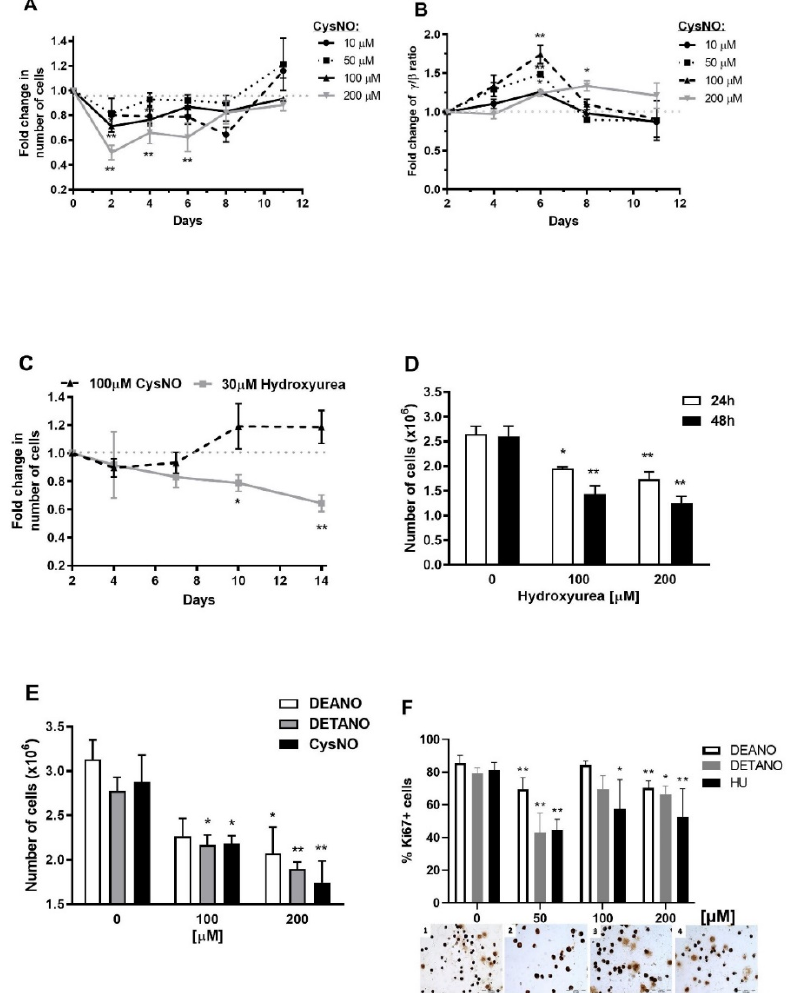
Figure 1. NO donors and hydroxyurea (HU) dose-dependent inhibition of human erythroid and erythroleukemic K562 cell growth and proliferation. Repetitive daily CysNO treatment of human erythroid progenitors and their ( A ) quantification and ( B ) ratio of γ / β globin gene expression at standing days during differentiation in the phase II medium; ( C ) single CysNO and HU treatment (at day 2) of erythroid progenitors; ( D ) 24 and 48 h treatment of K562 cells with HU; ( E ) 24 h treatment of K562 cells with NO donors: DEANO, DETANO, and CysNO; ( F ) Immunocytochemical analyses of the proliferative marker Ki67 positive cells after 24 h of DEANO, DETANO and HU treatment. Immunocytochemistry images correspond to the control and 200 µ M of DEANO, DETANO, and HU treatment. We started with 1 × 10 6 K562 cells. Values are mean ± SEM ( n = 4–6). * p < 0.05 and ** p < 0.01 compared to untreated